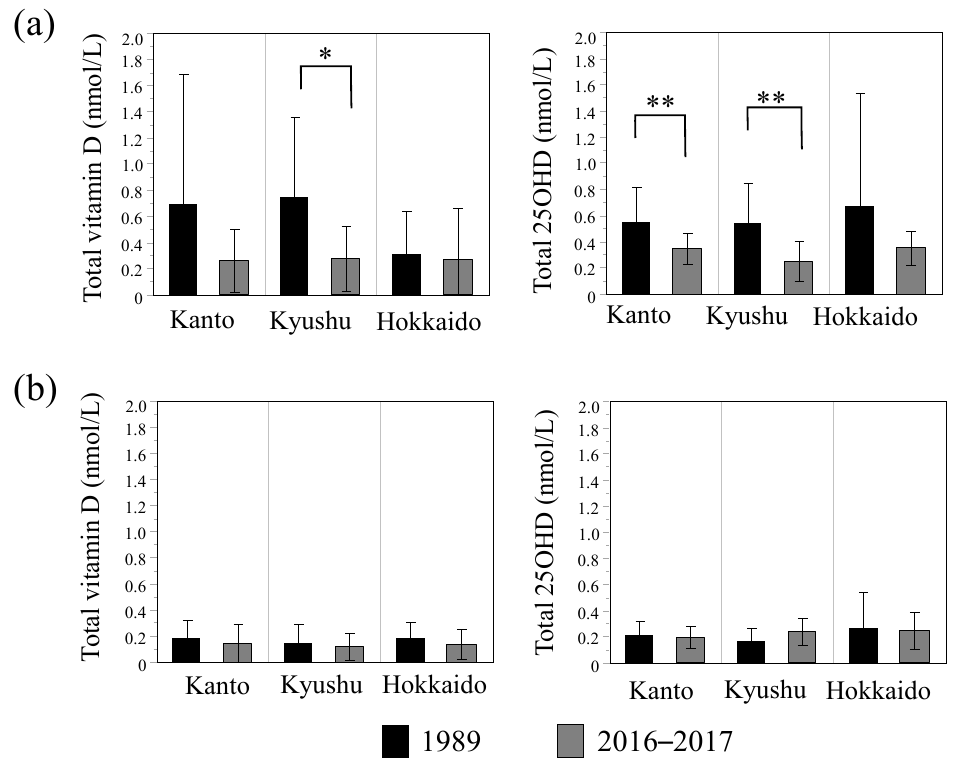
Figure 3. Breast milk vitamin D and 25OHD concentrations divided by season and region in 1989 and 2016–2017. Total vitamin D and Total 25OHD concentrations in summer ( a ) and winter ( b ). Solid bar: 1989, Gray bar: 2016–2017. Data are represented by the mean ± SD. Student’s t -test: * p < 0.05, ** p < 0.01.